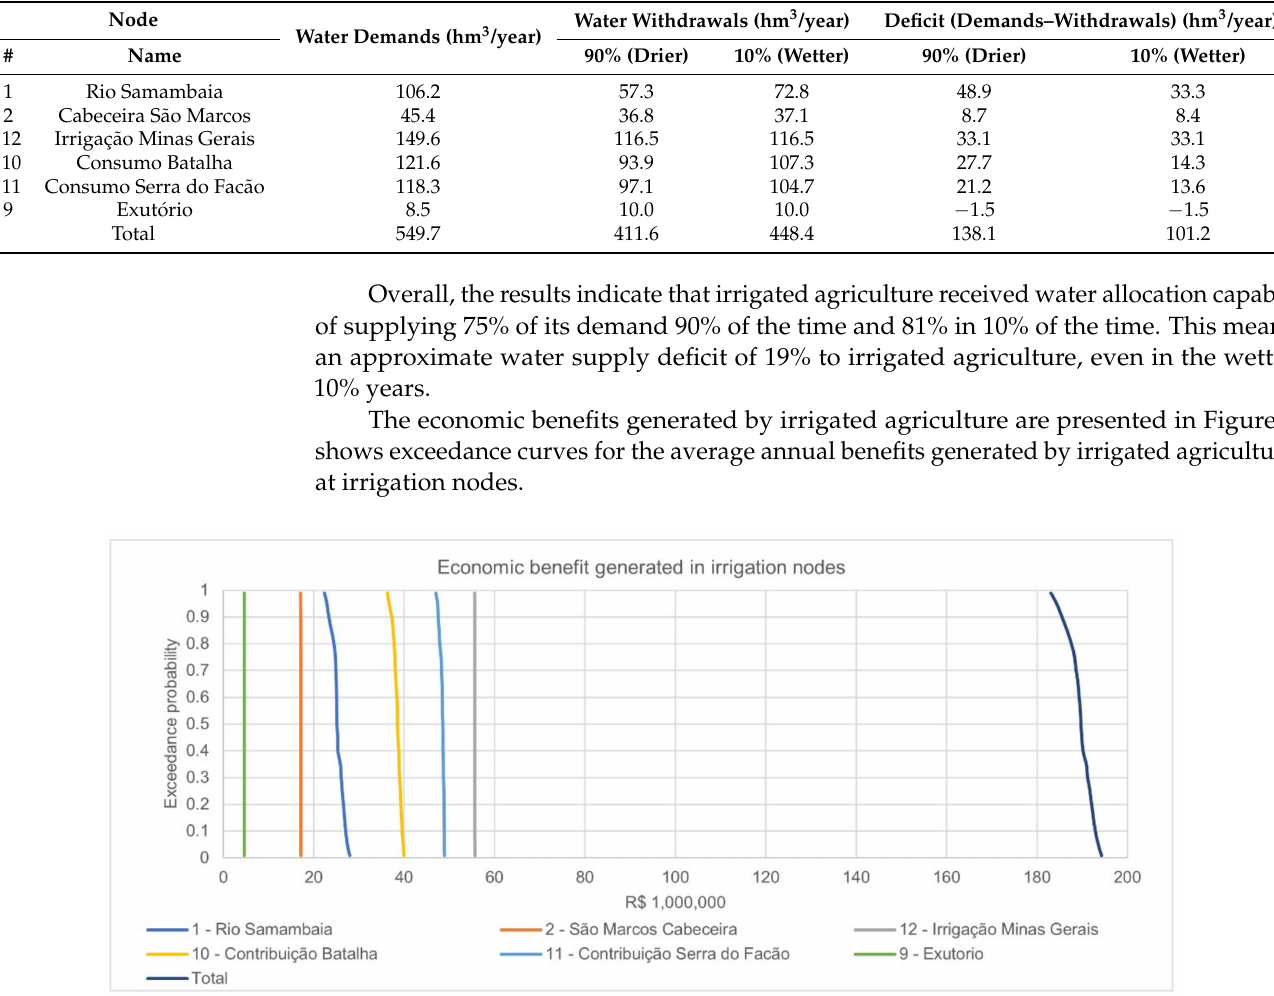
Figure 7. Exceedance curves for economic benefits generated by irrigation in each node of the